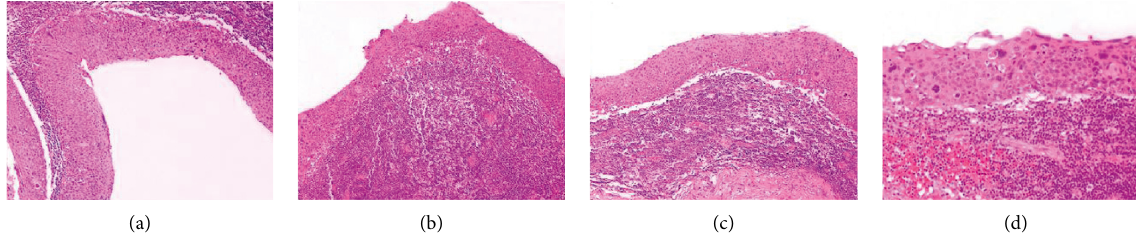
Figure 1: Histopathologic examination of the excised cervical lymph node revealed multiple cystic epithelial structures lined by stratified squamous epithelium exhibiting to a great extent malignant cytologic (hyperchromatic, irregular nuclei, mitotic figures) and architectural (loss of polarity) features (a); lying on dense lymphatic tissue focally forming lymphoid follicles with prominent germinal centers (b). The squamous cell epithelium lining of the cysts exhibited areas of transition (b, c) of moderate/severe dysplasia to in situ squamous cell carcinoma (d). A well-defined sinus tract was not present. Hematoxylin and eosin-stained slides of the cervical lymph node (a–d) at X40 (a, b, and c); and x200 (d)